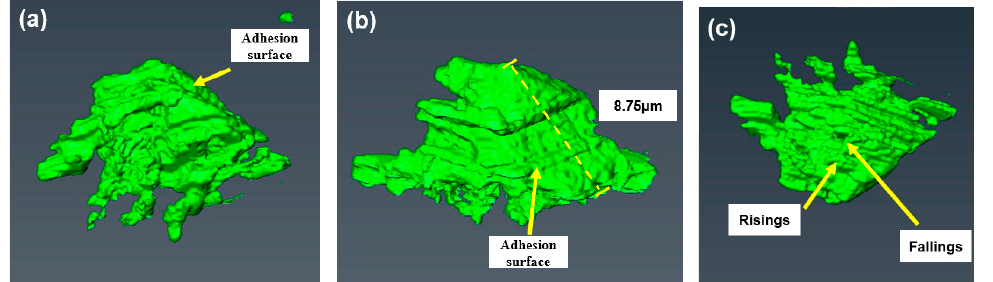
Figure 12. 3D morphology of secondary Widmanstätten sideplates from different perspectives. ( a )